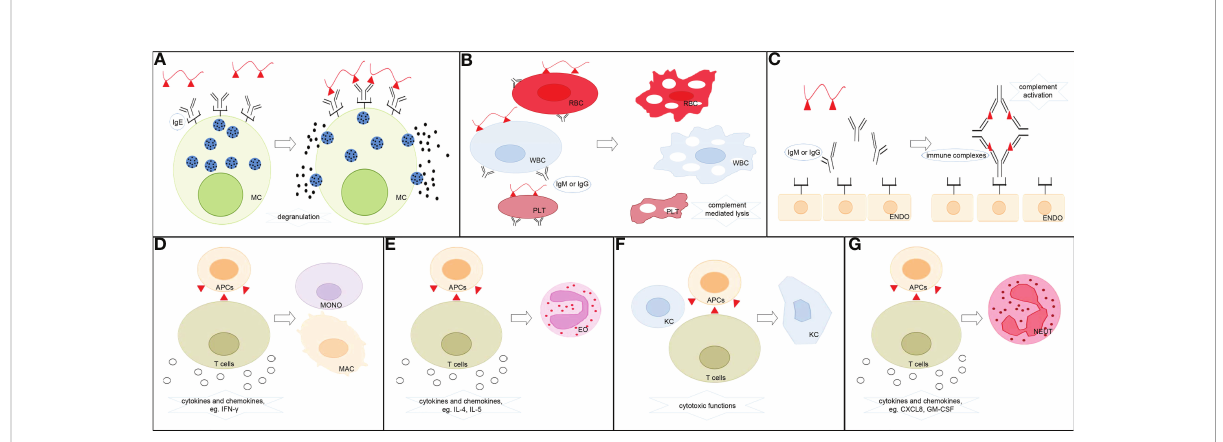
FIGURE 1 Classi fi cation of ADHRs. (A) Type I ADHRs. Drugs stimulate the generation of drug-speci fi c IgE, which binds to high-af fi nity IgE receptors on the surface of mast cells and basophils. The drugs then react with speci fi c IgE – effector cell complexes and induce the release of histamine and other in fl ammatory mediators. (B) Type II ADHRs. Speci fi c IgG or IgM antibody-coated cells encounter complement-dependent cytotoxicity to induce cell lysis. (C) Type III ADHRs. Deposition of drug – antibody complexes activates the complement system or other immune cells to induce in fl ammation and injury. (D) Type IVa ADHRs. Th1 cells mediate macrophage/monocyte activation. (E) Type IVb ADHRs. Th2 cells mediate eosinophil activation. (F) Type IVc ADHRs. Cytotoxic T cells act as effector cells to produce cytotoxic mediators and kill tissue cells. (G) Type